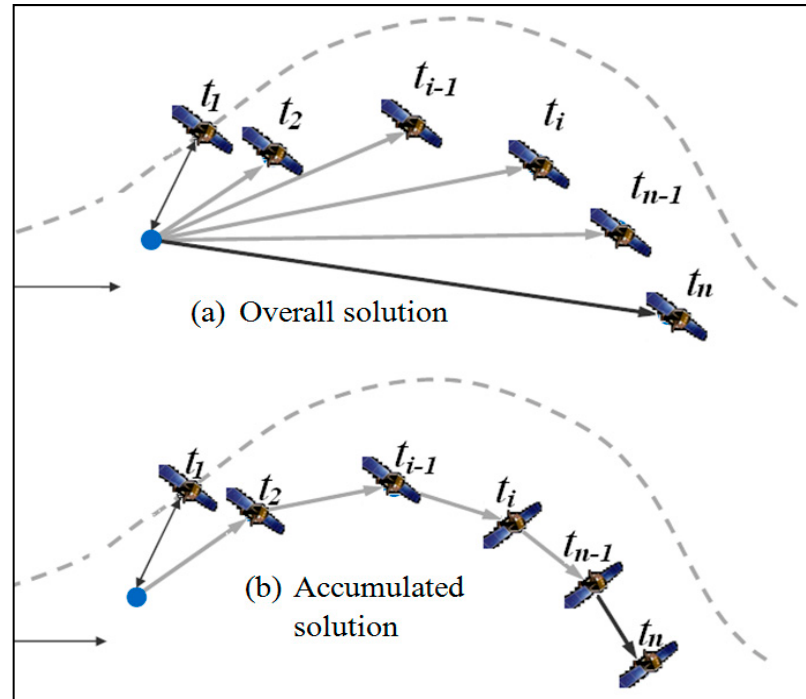
Figure 2. Overall time-relative method vs. accumulated time-relative positioning method.